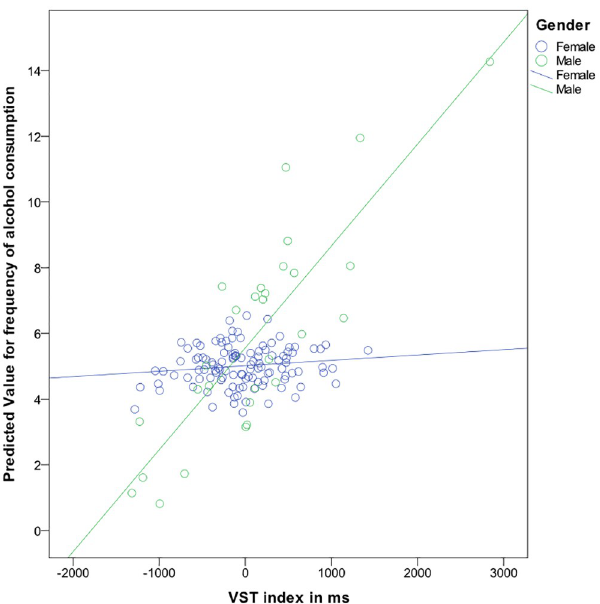
Fig 3. Frequency of alcohol consumption for males and females by AB as measured with the